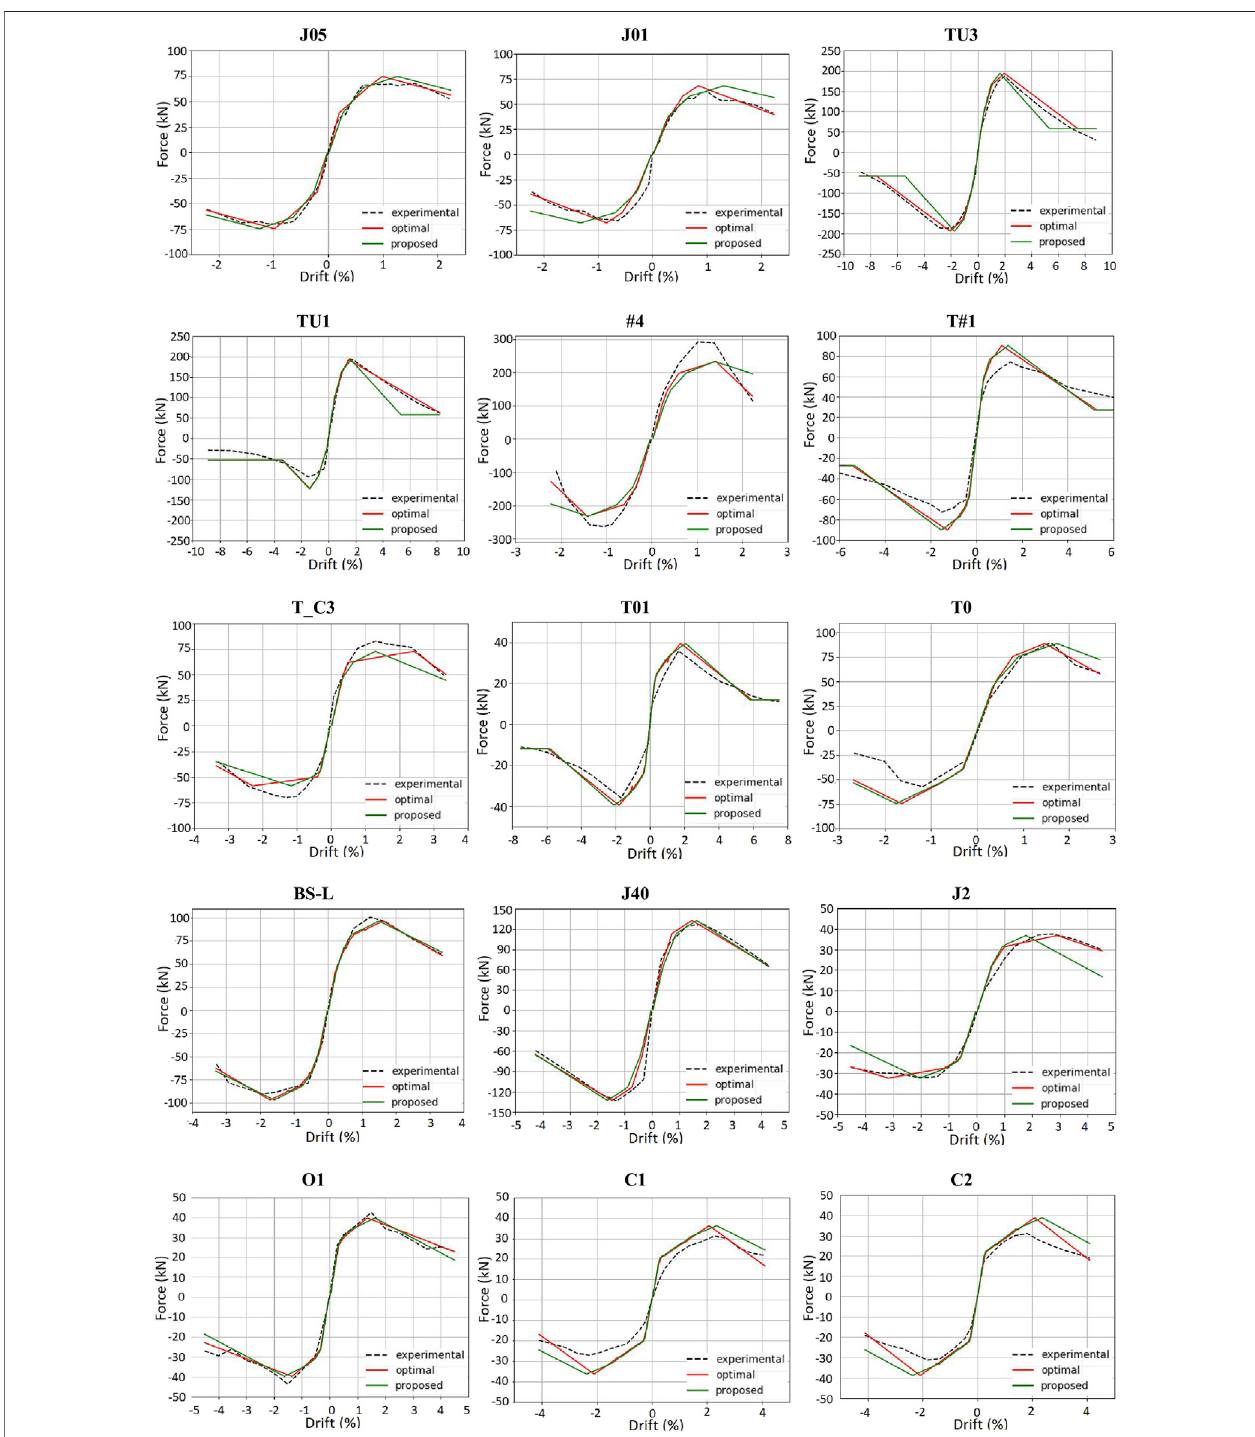
FIGURE 8 | Numerical vs Experimental comparison of the monotonic envelopes considering the “ optimal solution ” (red curve) and the “ proposed model ” (green curve).